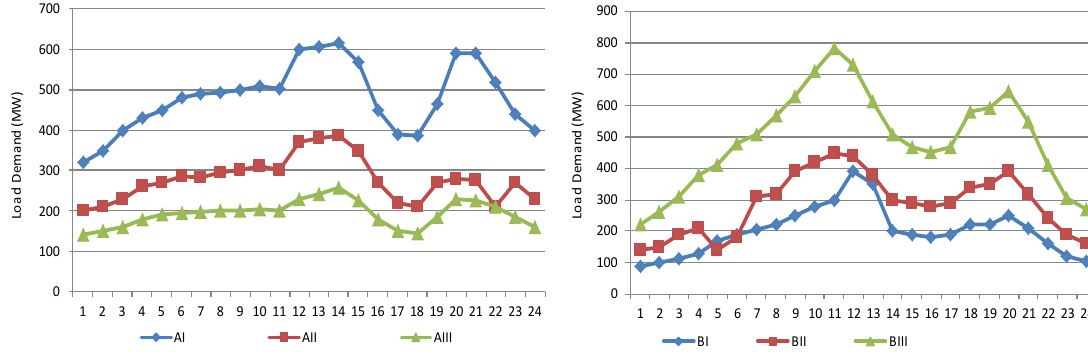
Figure 2. Load distribution of various users in different voltage ranges (MW).